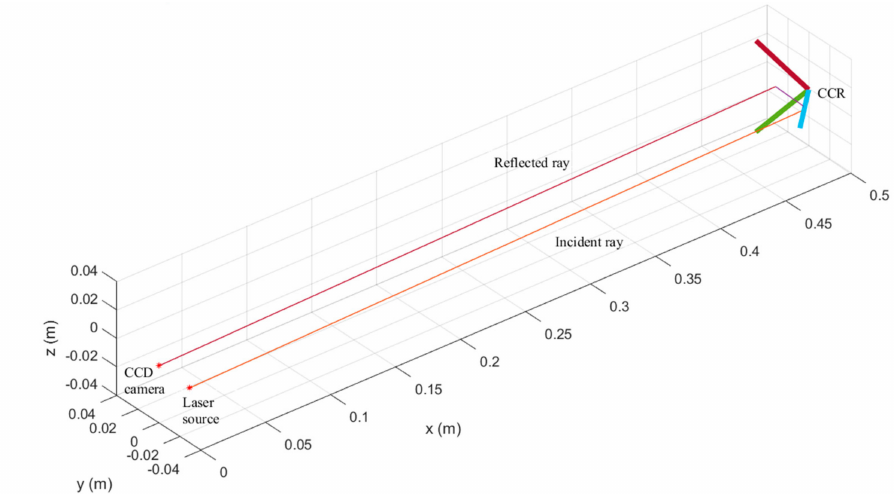
Figure 12. Simulation scenario of tracking and localization by the proposed method, showing the optical path.